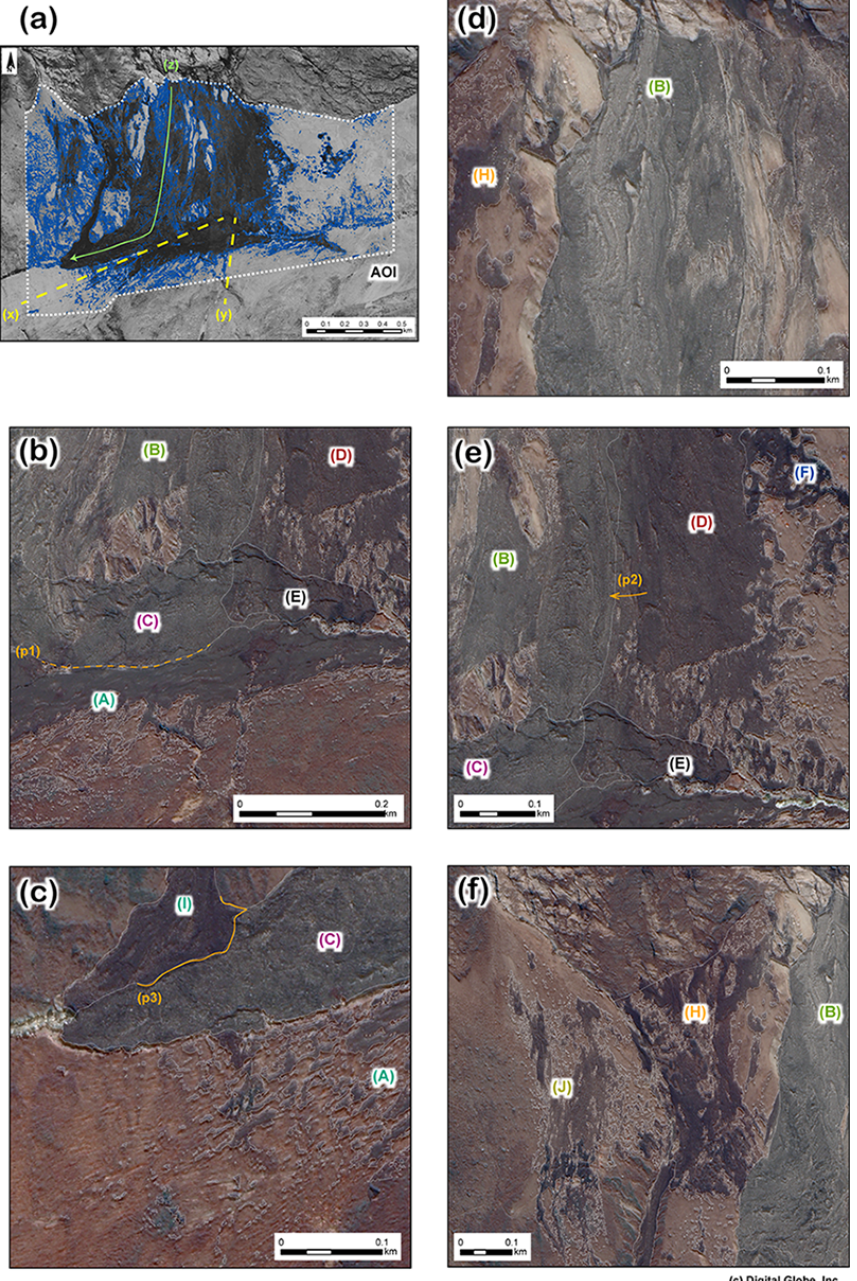
Figure 4. Details of sediment mapping (a) . Unsupervised classification was initially applied to the WV-3 thermal infrared image (b–f) . De- tailed interpretation and classification were carried out by comparing the differences in sediment colours and physical characteristics.